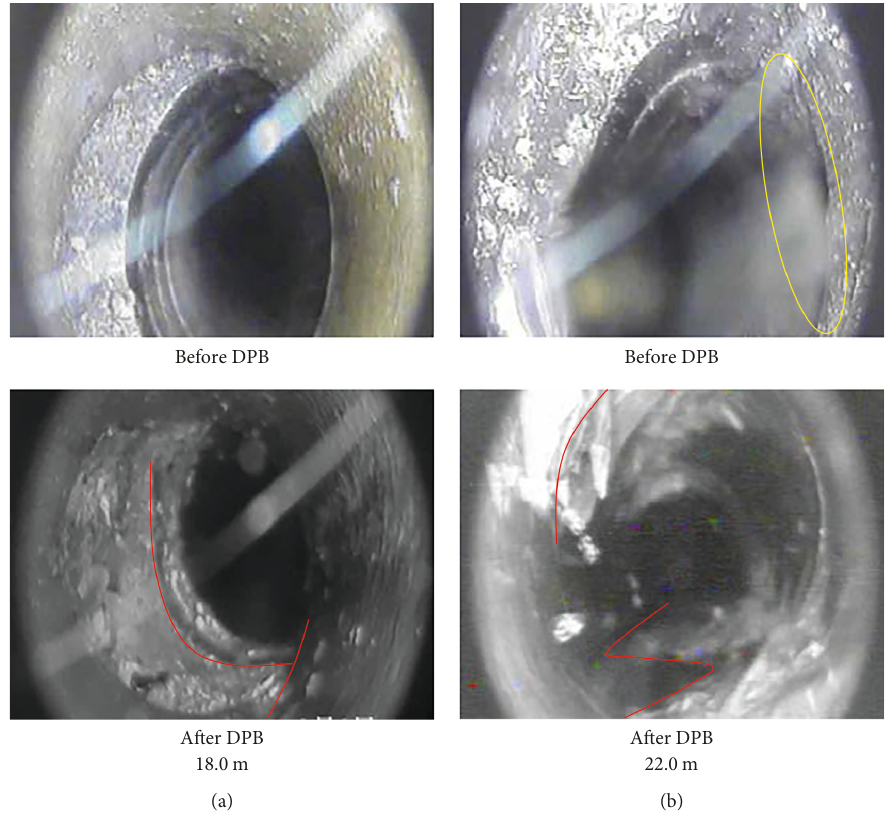
Figure 22: Typical screenshots at different holes depth before and after DPB. (a) 18.0m. (b)